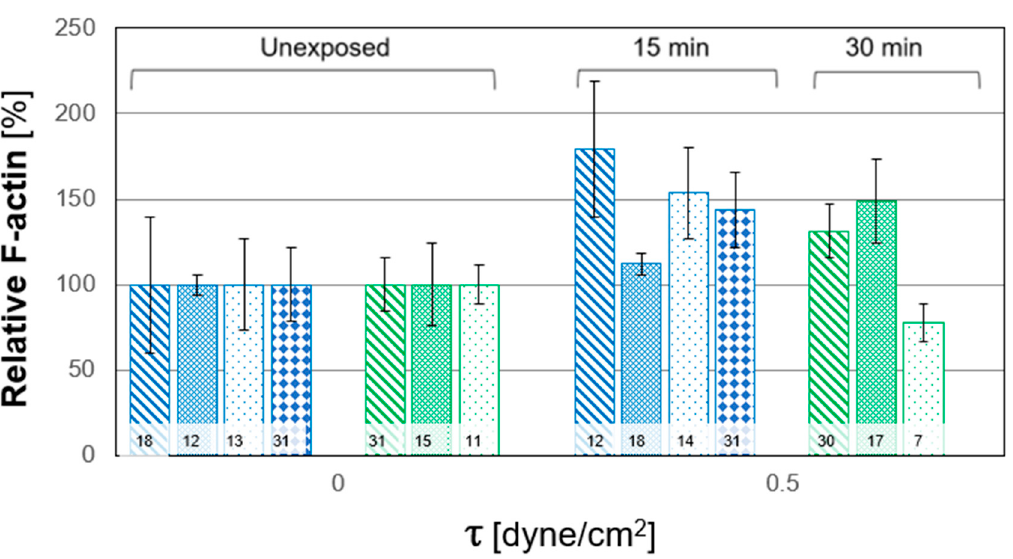
Figure 5. Relative alterations of cytoskeletal F-actin in human conjunctival epithelial cell (HCEC) in vitro model in single tests with HCEC cultured from different subjects. The cultures were exposed to wall shear stresses (WSS) of 0.5 dyne/cm 2 for durations of 15 min (4 repetitions) and 30 min (3 repetitions). Columns with the same pattern and color represent the control and those after exposure to WSS in a single test. The data obtained after exposure to WSS were scaled by the averaged data for the unexposed control. The values inside the bars denote the number of data points calculated from the sub-regions (n).